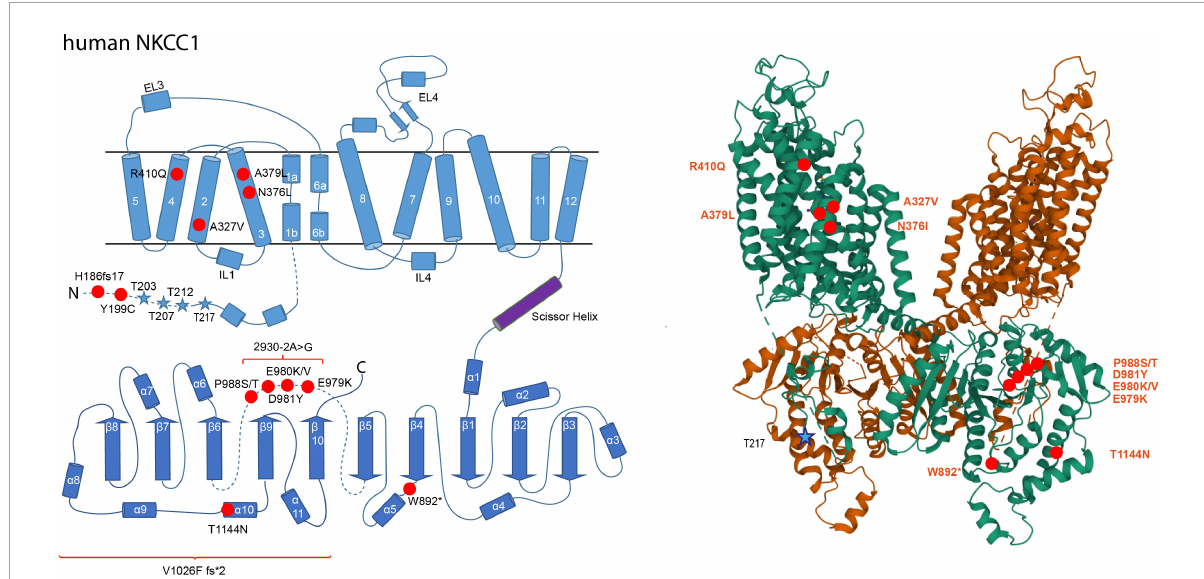
FIGURE3 Structural organization of human NKCC1. 2-dimensional (left) and 3-dimensional (right) organization of human NKCC1 (A) according to Zhao et al. (2022) (PDB: 7S1X). NKCC1 consists of 12 transmembrane domains (TMs) and two intracellular termini. A large extracellular loop is located between transmembrane domains 7 and 8 (EL4). Phosphorylation sites that increase NKCC1 activity upon phosphorylation are marked as blue stars (Thr 203 , Thr 207 , Thr 212 , and Thr 217 ). Human pathogenic variants of NKCC1 associated with autism spectrum disorder, schizophrenia, multisystem dysfunction, spastic quadriparesis, and hearing impairment are depicted as red dots in human NKCC1 (His 186 fs 17 , Tyr 199 Cys , Ala 327 Val , Asn 376 Leu , Ala 379 Leu , Arg 410 Glu , Trp 892 ∗ , Gln 979 Lys , Asn 981 Tyr , Pro 988 Ser , Pro 988 Thr , Thr 411 Asn , 2930.2A > G, Val 1026 Ffs ∗ 2 ). The 3D reconstruction of NKCC1 was generated using cryo-EM (Zhao et al., 2022). 3D visualization was performed using Mol* Viewer in PDB (Sehnal et al.,